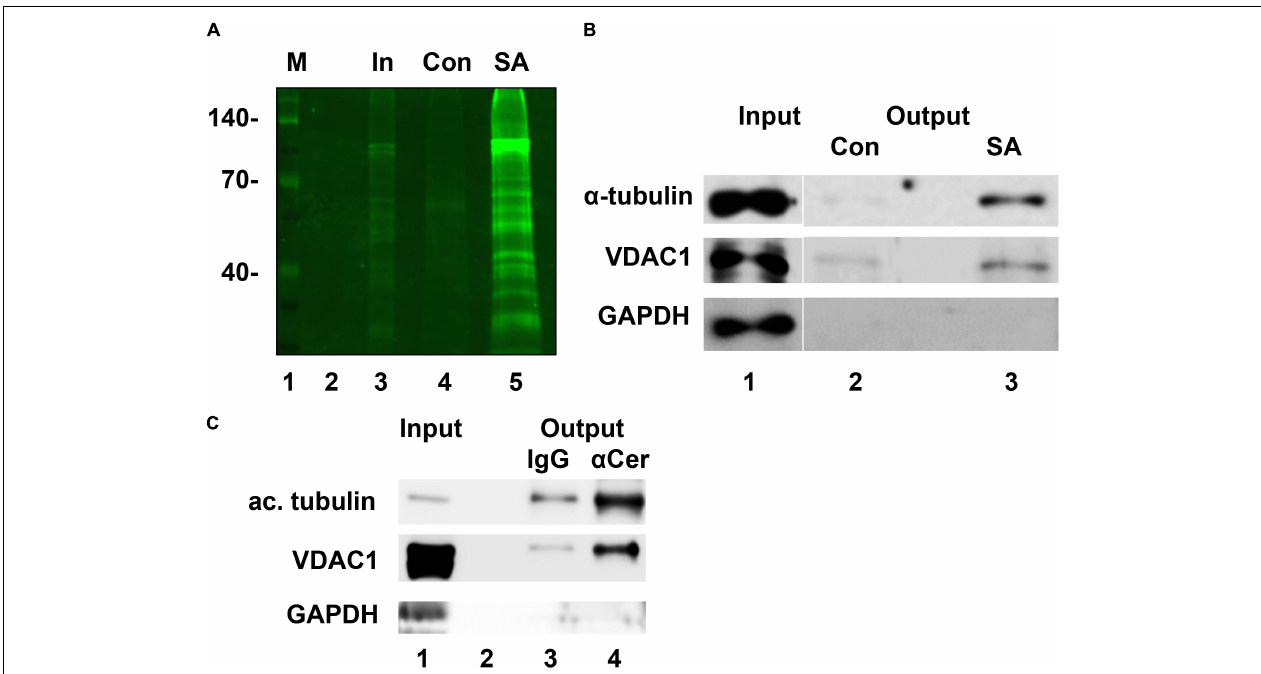
FIGURE 2 | Tubulin and VDAC1 are cross-linked to pacFACer and associated with ceramide vesicles. (A) N2a cells were incubated with pacFACer, UV cross-linked, and fixed with ice-cold methanol. Cells were scraped off, pelleted, and protein solubilized with 1% SDS in PBS. The copper-mediated click addition was performed using TAMRA-biotin-azide and non-incorporated reagent removed by chloroform/methanol extraction. Precipitated protein was re-solubilized and pacFACer cross-linked protein isolated by pull-down with streptavidin beads. Bound protein was eluted by heating in SDS sample buffer and separated by SDS gelectrophoresis. Lane 1, marker; lane 2, empty; lane 3, input used for streptavidin pull-down; lane 4, pull-down with streptavidin beads saturated with biotin (control); lane 5, pull-down with streptavidin beads (SA). (B) Assay performed as described in (A) , but gel immunoblotted and probed with antibodies to tubulin, VDAC1, and GAPDH. (C) Coimmuniprecipitation of acetylated tubulin and VDAC1 using antibody to ceramide to precipitate ceramide-enriched vesicles from lysates of HEK293T cells (lane 4). Non-specific rabbit IgG was used as the control (lane 3). Lane 1, input; lane 2, empty. GAPDH was not